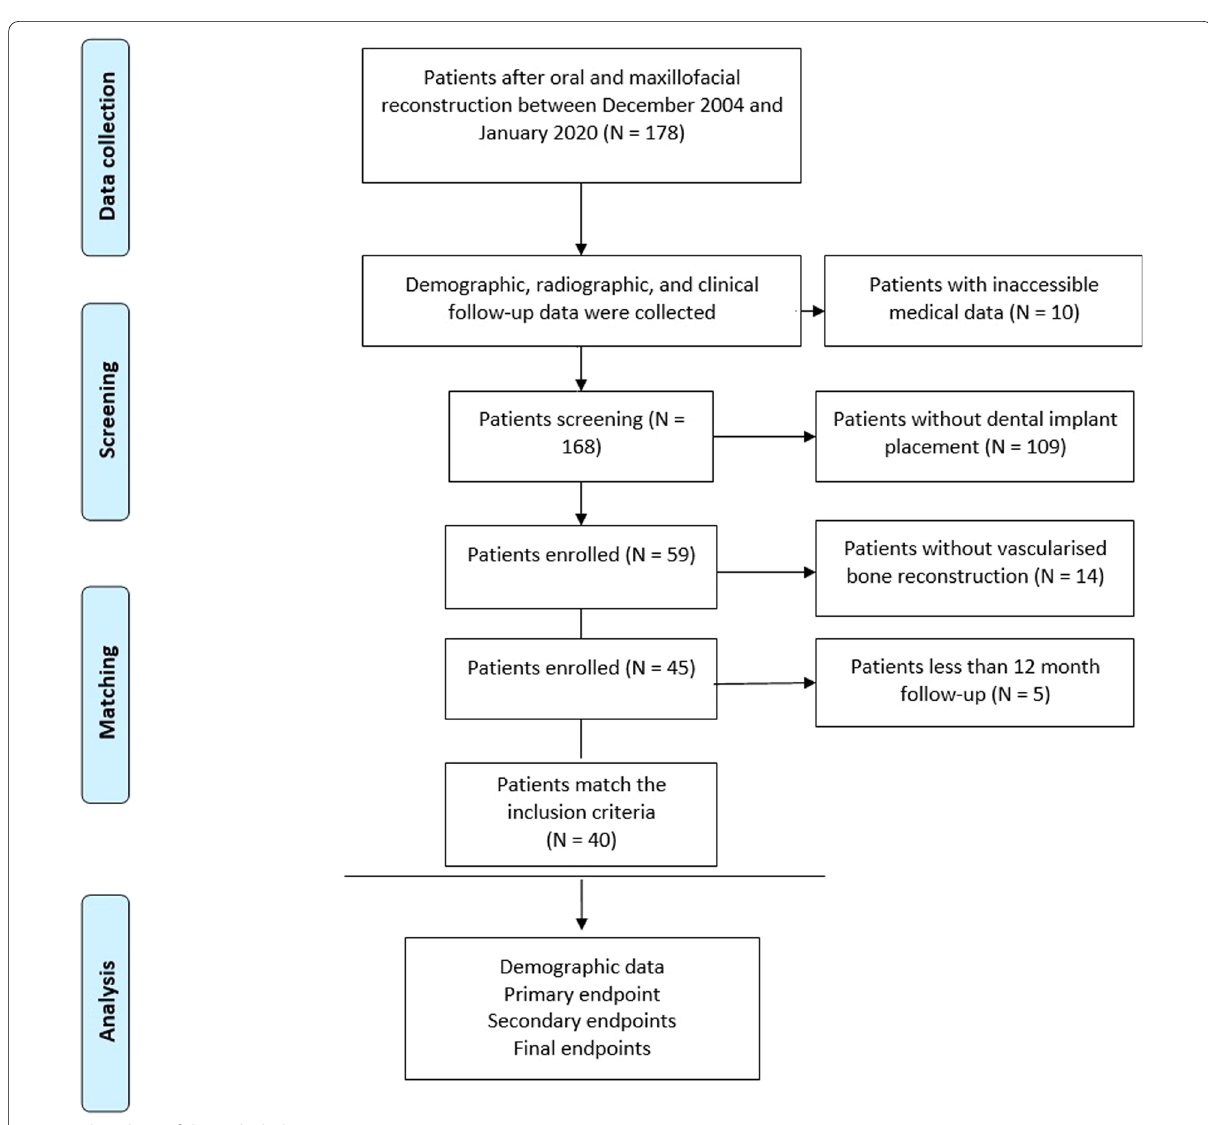
Fig. 2 Flowchart of the included